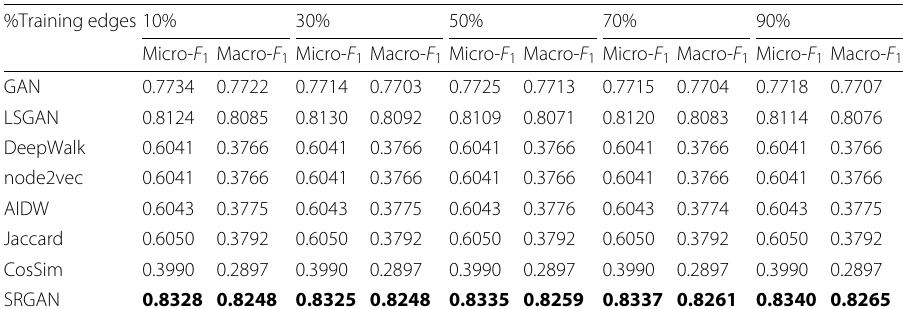
Table 2 Micro- F 1 and Macro- F 1 scores on CitNet dataset in link prediction ( α = 0.1, β =